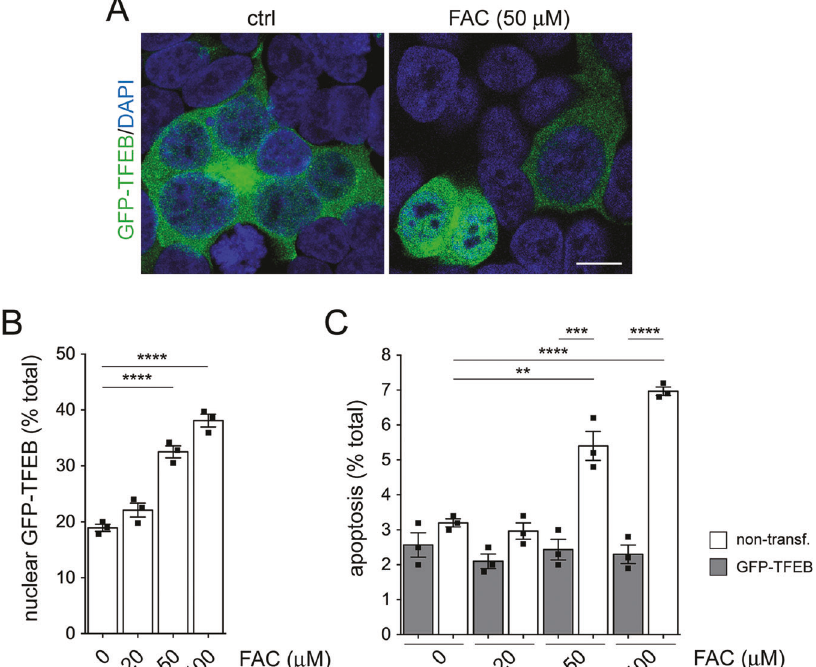
Fig. 4 TFEB expression reverts apoptosis due to iron overload. A Representative example of HEK293T cells transfected with GFP-TFEB and with or without FAC treatment (50 μ M, 48 h). Scale bar, 10 μ m. B Cells were treated with increasing concentrations of FAC for 48 h as indicated. The percentage of cells with nuclear GFP-TFEB accumulation was quanti fi ed from 200 – 400 transfected cells per condition and experiment. C As in B , but quanti fi cation of apoptosis from 200 – 400 non-transfected versus transfected cells in the presence of increasing concentrations of FAC for 48 h. Bars represent mean ± s.e.m. (**** p < 0.001; *** p < 0.005; ** p <